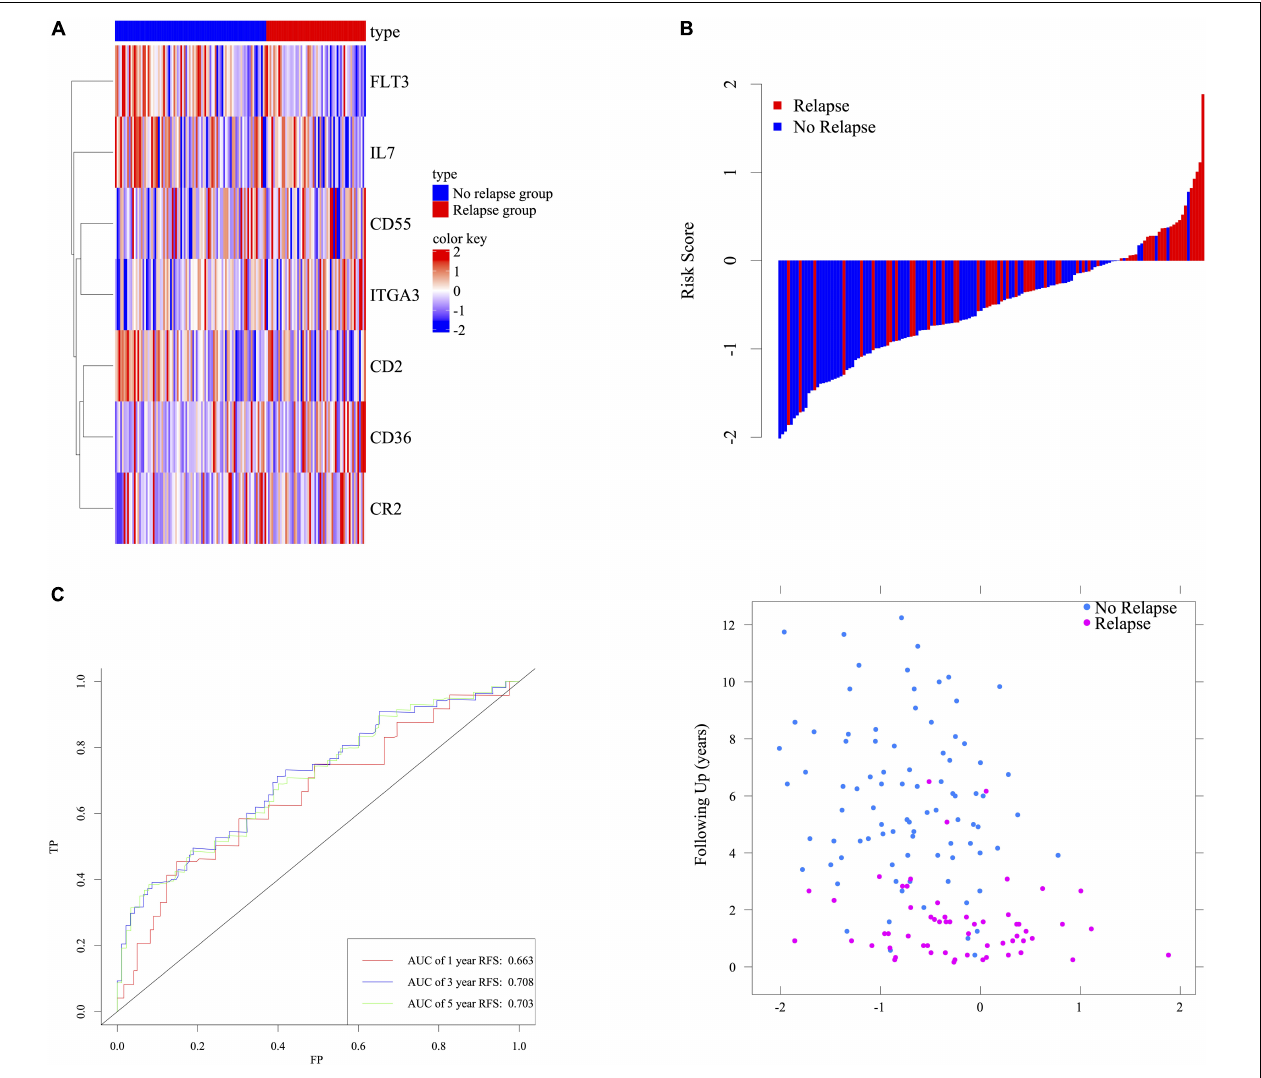
FIGURE 3 | Determination and analysis of the seven-HCL-related signature in GSE39582 cohort. The expression pattern of the seven-HCL-related signature (A) . The distribution of patients’ risk score and relapse status (B) . Time dependent ROC curves at 1, 3, and 5 years (C)